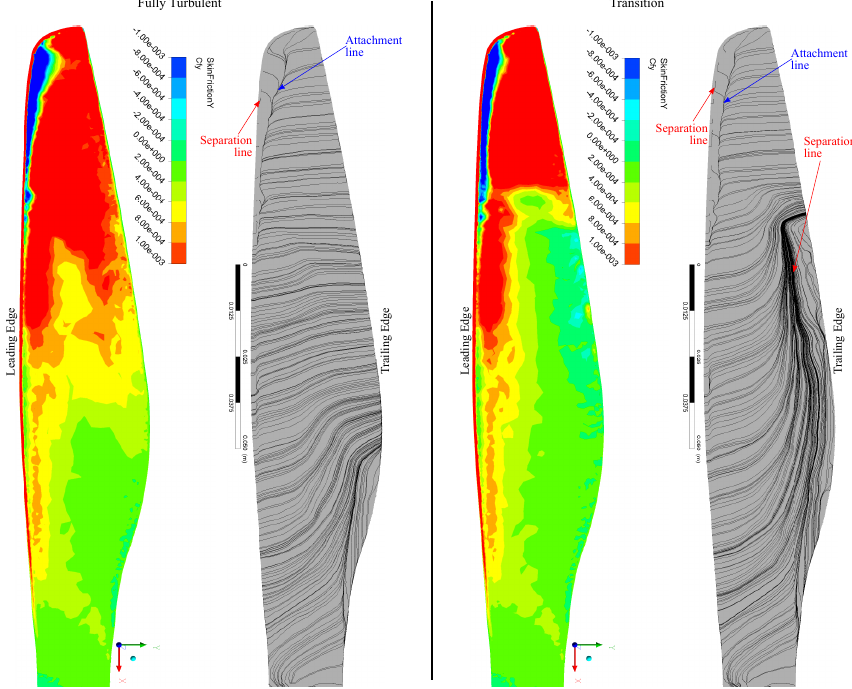
Figure 11. Skin-friction coefficient and surface streamlines for Re = 1.15 × 10 5 on the upper surface. From surface streamlines, a separation line is observed on the leading edge and the line where the boundary layer re-attaches. This separation zone is also present for lower rotational velocities, though the attachment line is farther from the separation line; i.e., the boundary layer takes longer to re-attach. These features at the leading edge (close to the tip) are similar to those predicted by the fully turbulent model. The fully turbulent model does not show another separation region except close to root at the trailing edge. In contrast, the transition-turbulence model shows a clear separation line close to the trailing edge from the mid-span to the root. This is also evident in the skin-friction contours, showing a change in the sign of the skin-friction coefficient (cyan region) but not as strong as for the leading edge separation. Furthermore, these surface streamlines suggest a cross-flow zone with a high velocity in the "X" direction from the root to the mid-span. This cross-flow section is stronger close to the trailing edge, and it is also present for lower Re approaching the tip as the Re decreases. The fully turbulent model also presents this cross-flow but at lower Re (not shown, further details are found on reference [19]), and as for the case of the transition-turbulence model, the cross-flow gets closer to the tip when the velocity reduces. Serre et al. [10] used oil flow visualization of a rotor that was tested at 5000 RPM;